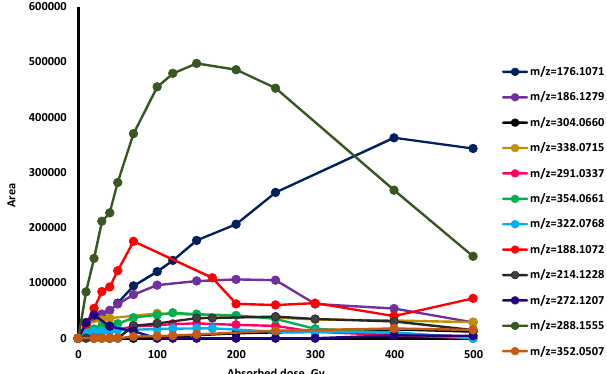
( B ) Figure 8. Cytotoxicity monitoring ( A ) citalopram against HepG2 ( B ) citalopram towards Caco2. 3.6. Preliminary Identification of Degradation Product Our previously described experiments on the decomposition of SER and CIT under the conditions of dominance of one selected product of water radiolysis showed that the decomposition of both SER and CIT occurs with the highest efficiency in the presence of hydroxyl radicals. Considering the complicated chemical structure of SER and CIT as well as the high reactivity of hydroxyl radicals, many potential sites of attack of the hydroxyl radical on the molecule of the selected pharmaceutical have been postulated [53]. It has been shown that the products formed in the photocatalytic degradation of SER include its